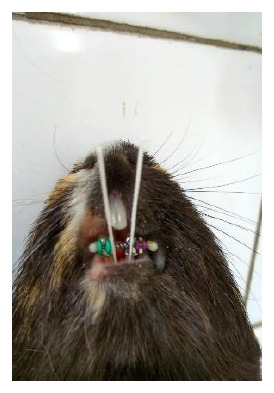
Installation of bracket and gingival crevicular fluid isolation.